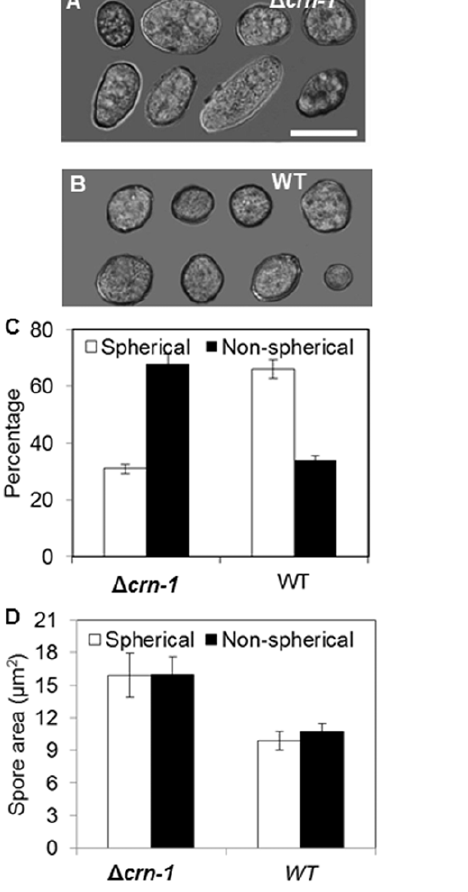
Figure 8. Comparison of conidial morphology and size. Conidiophores of (A) D crn-1 mutant and (B) WT strain. Composite image of conidia representing the most common shapes in (C) D crn-1 mutant and (D) WT strain. (E) Relative abundance of spherical and non- spherical conidia in the D crn-1 mutant and WT strain. (F) Average size of conidia in the D crn-1 mutant and WT strain. The error bars represent the 95% confidence interval. Scale bar=5 m m.